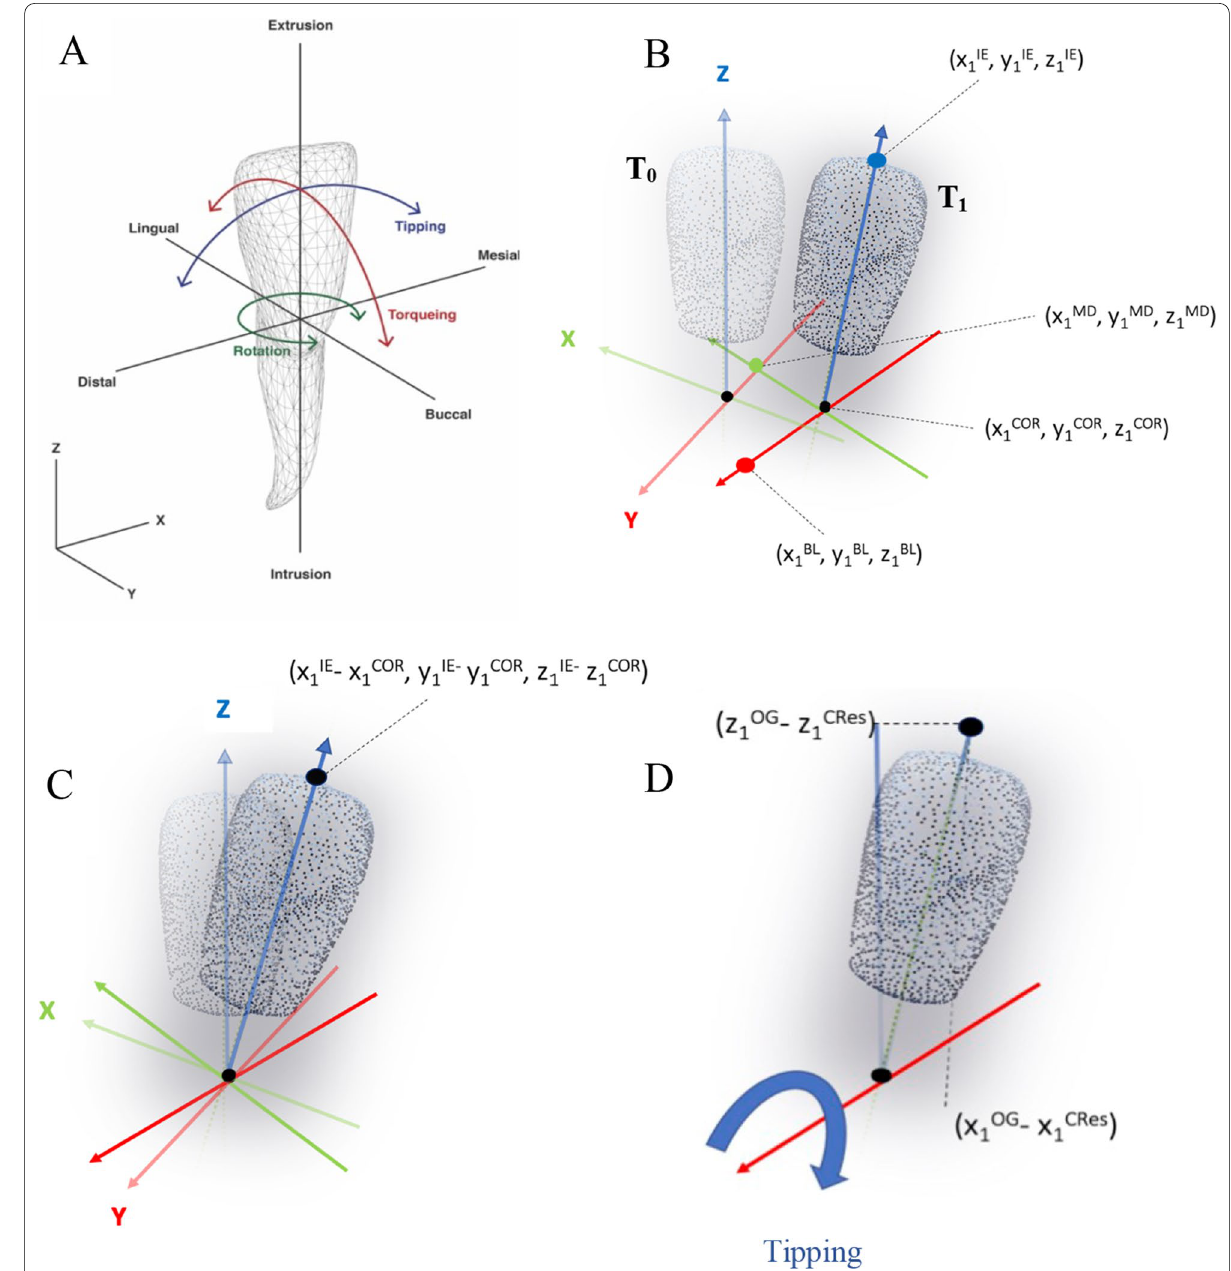
Fig. 1 Method used to measure lower incisor tip: A diagrammatic drawing showing tooth movement as described with six degrees of freedom. The axes are orientated so that the x -axis represented mesio-distal (MD), the y-axis represented bucco-lingual (BL), and the z -axis represented occluso-gingival (OG) directions. B The C Res was placed at a set distance from the intersection of the crown mesh and the long axis of the tooth (black dot). Arbitrary points were also placed at set distances along the x , y and z axes. C The origin of the three axes at T1 reorientated to coincide with C Res of T0. D Tipping movement assessed as the rotation around the y (bucco-lingual)-axis was then calculated using